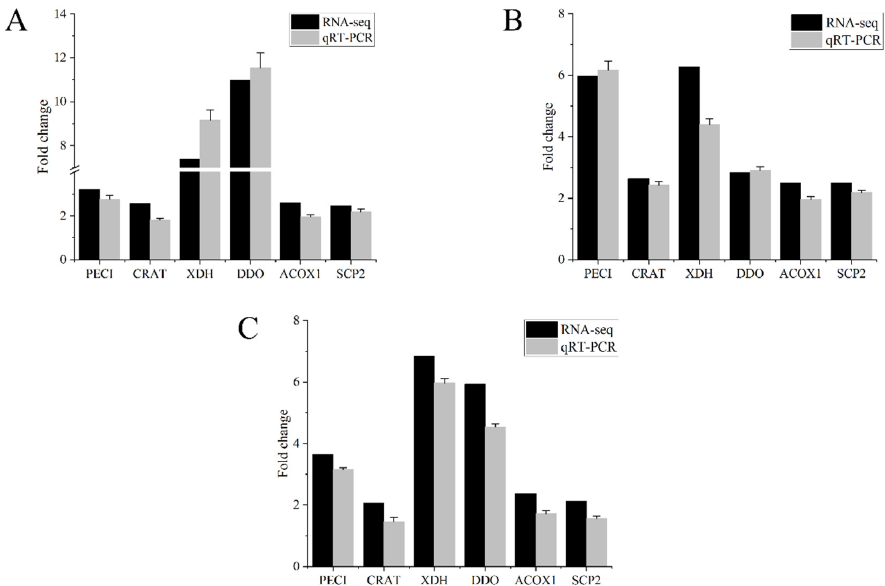
Figure 7. Validation of RNA-seq gene expressions in P. clarkii hepatopancreas by qRT-PCR: ( A ) Low concentration of Hg (8.75 μ g/L Hg 2+ ). ( B ) Med concentration of Hg (21.875 μ g/L Hg 2+ ). ( C ) High concentration of Hg (43.75 μ g/L Hg 2+ ).